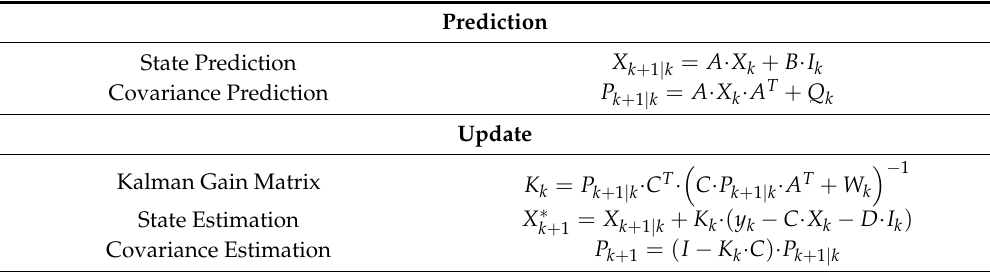
Table 3. The process of EKF for SOC